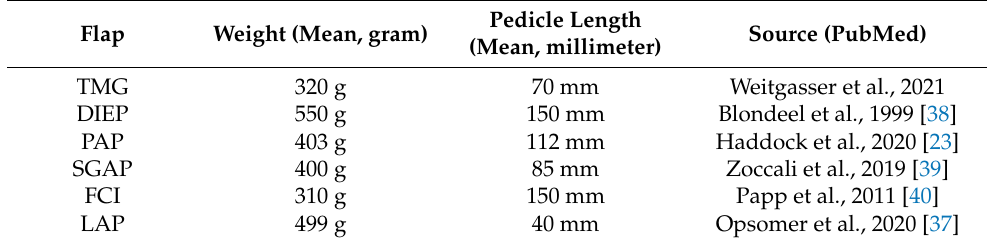
Table 5. Overview of the common used free flaps for breast reconstruction and their